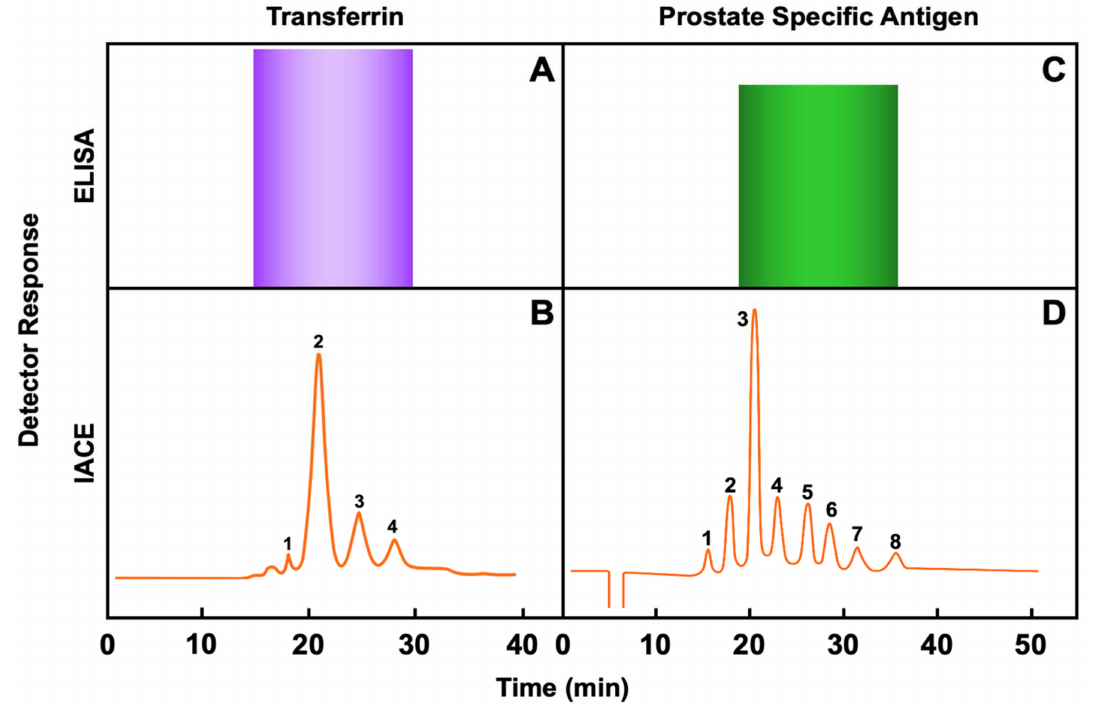
Figure 7. Depicts comparative results of two isoforms using ELISA, a monodimensional immunoassay, and IACE, a two-dimensional immunoassay. ( A ) depicts the analysis of transferrin using the ELISA method, and ( B ) depicts the analysis of transferrin using the IACE method. ( C ) depicts the analysis of prostate specific antigen (PSA) using the ELISA method, and ( D ) depicts the analysis of PSA using the IACE method. Figures modified from